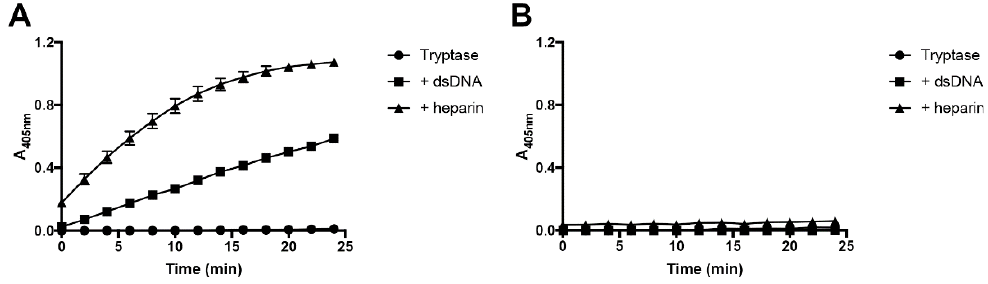
Figure 4. DNA or heparin do not rescue the activity of inactivated tryptase. ( A ) β -tryptase (0.07 μ g) was incubated at 37 °C for 3 h in the absence or presence of either heparin or dsDNA, followed by measurement of residual tryptase activity using S-2288. ( B ) Human β -tryptase (0.07 μ g) was enzymatically inactivated by incubation in the absence of heparin or dsDNA for 3 h (37 °C). After complete inactivation (3 h), tryptase was further incubated for 30 min, either alone or in the presence of either heparin or dsDNA as indicated. Tryptase activity was then measured using the chromogenic substrate S-2288. The data are representative of three independent experiments. Data are given as mean values ± SD ( n = 3).